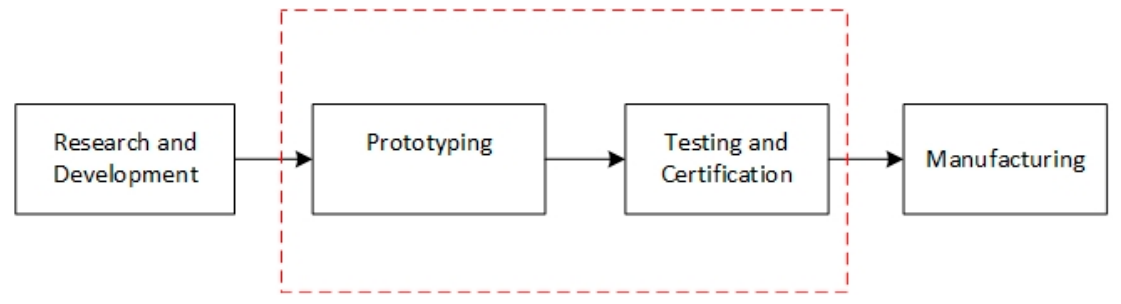
Figure 1. Stages of a new product development (NPD) process from an engineering perspective.